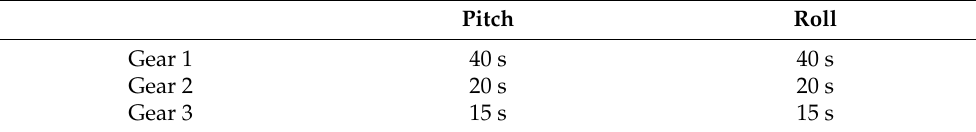
Table 3. Rolling period.